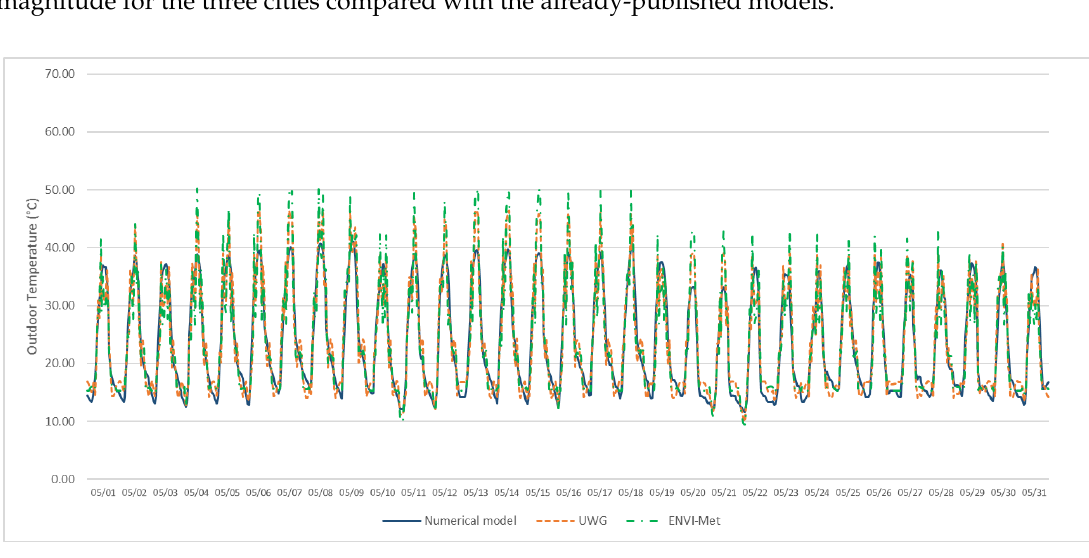
Figure 11. Hourly outdoor temperatures for May on New Delhi comparing the numerical model developed here, UWG, and ENVI-Met.